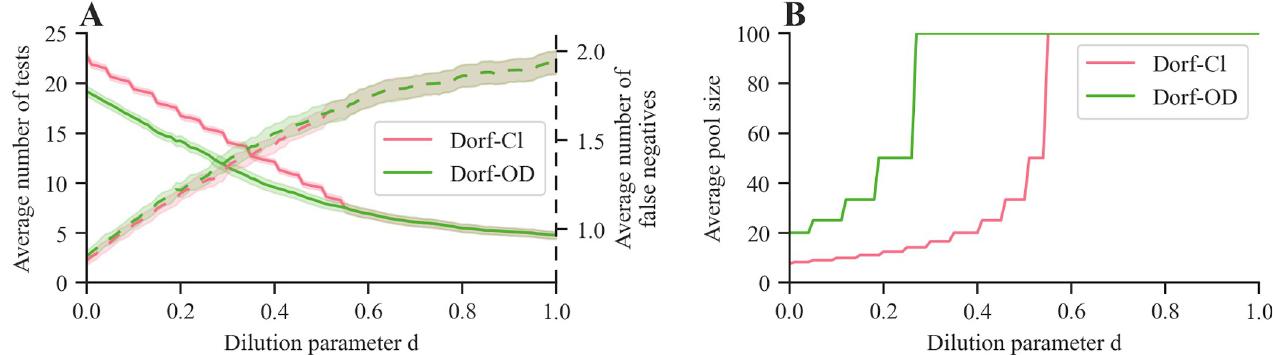
Fig 4. Performance of our method (Dorf-OD) and classic Dorfman’s method (Dorf-Cl) for various values of the dilution parameter d. Panel ( A ) shows the average numbers of tests (solid lines) and false negatives (dashed lines). Panel ( B ) shows the average pool size. In both panels, shaded regions represent 95% confidence intervals. Here, we set N = 100, R = 2.5, k = 0.1, s e = 0.8, s p = 0.98 and, for each combination of method and parameter value, the averages are estimated using 10,000 samples.